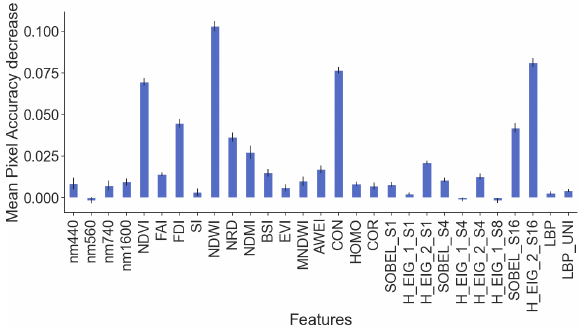
Figure 3. Mean Accuracy Pixel Decrease of 29 non high correlated features based on Random Forest Permutation method. SOBEL σ sort for Sobel filter of the Gaussian of standard deviation σ . H EIG λ σ sort of Hessian Eigenvalue λ (1st or 2nd) of the Gaussian of standard deviation σ